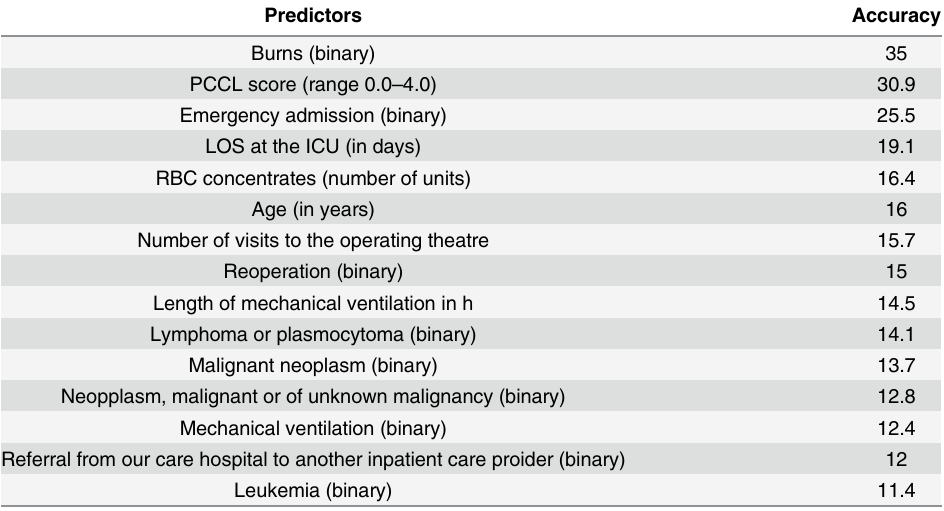
Table 5. 15 most important predictors for profit outliers defined by the IQR method derived from Ran- dom forest analysis. Predictors were ordered according to the order of magnitude of their accuracy (n = 20,000, training